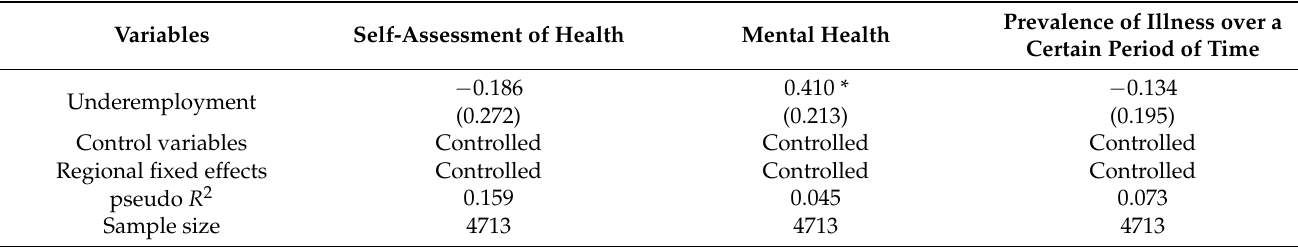
Table 7. Long-term effects of underemployment on workers’